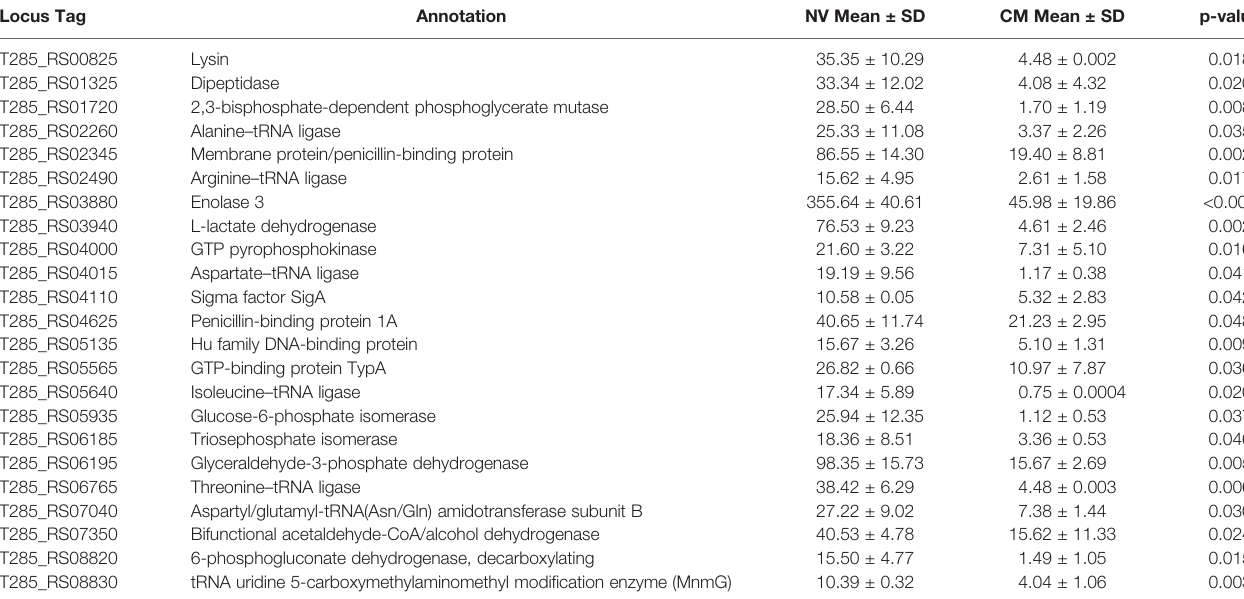
TABLE 4 | Enriched protein composition found within the NV as compared to the CM of L. johnsonii N6.2. Locus